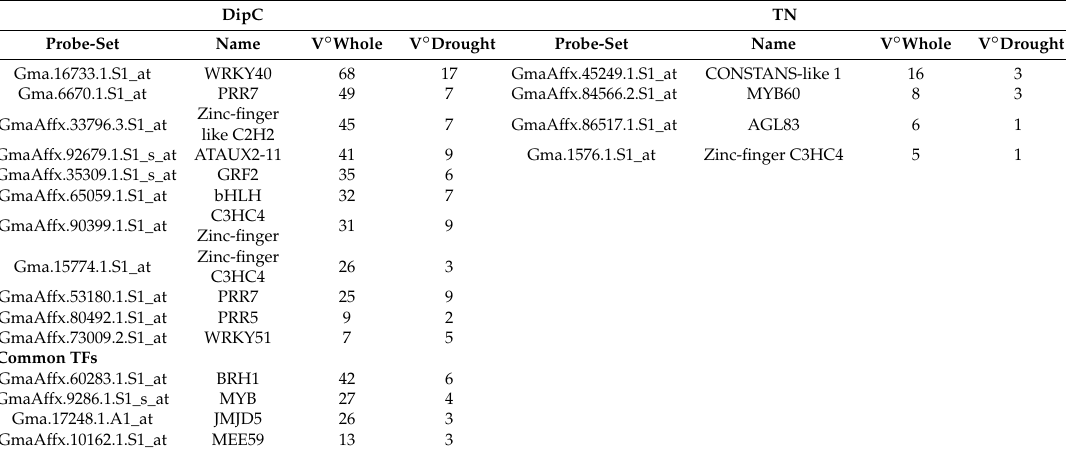
Table 6. Vertex degrees of differentially expressed transcription